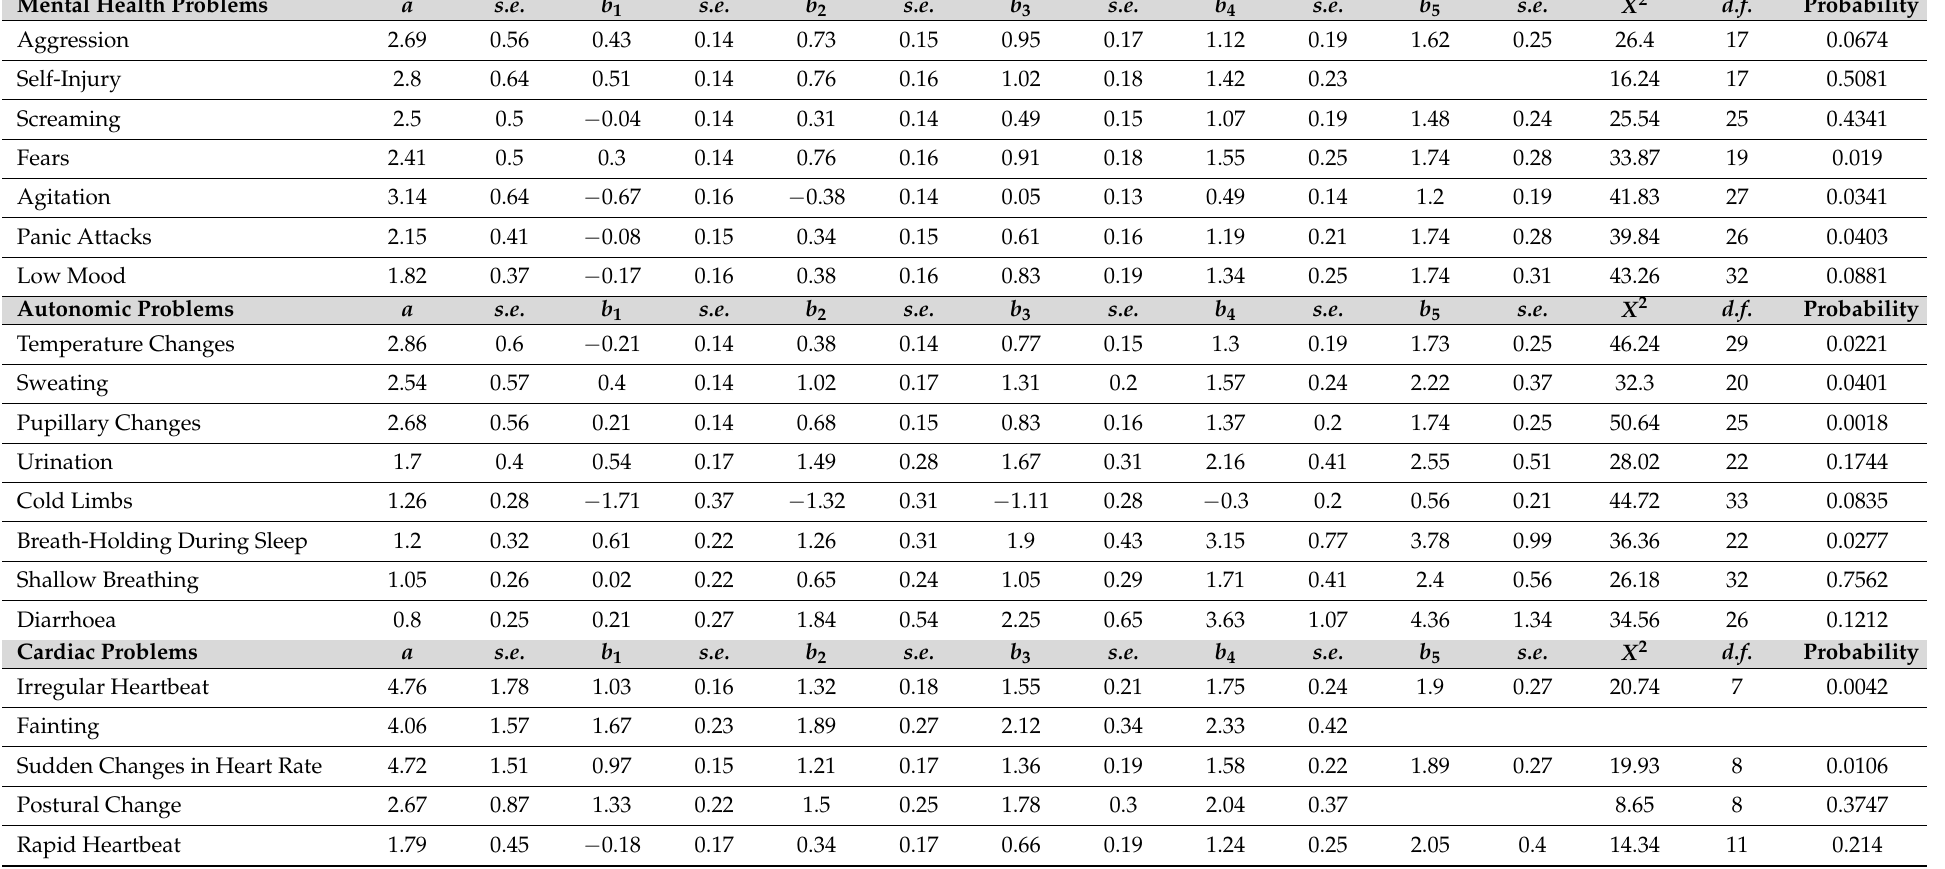
Table 1. Multi-System Profile of Symptoms Scale—Item Response Theory